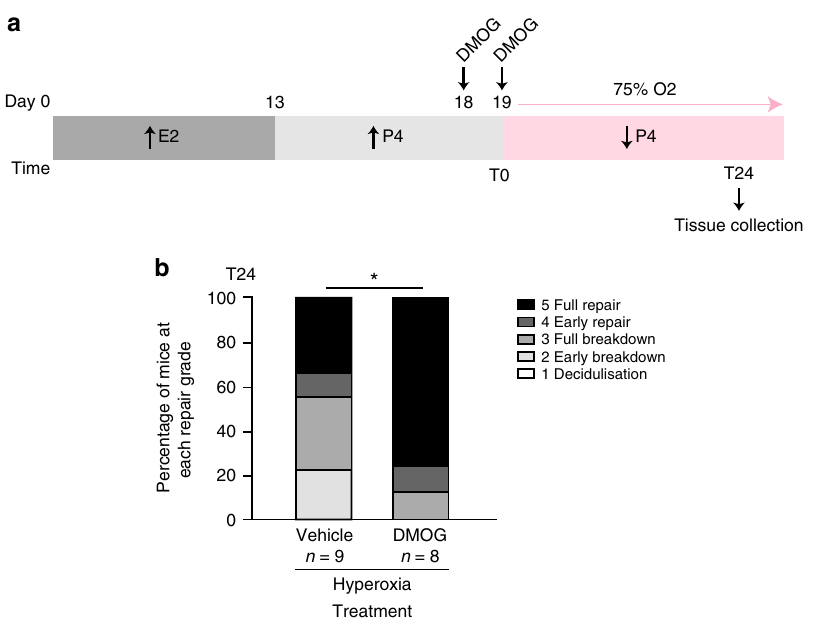
Fig. 6 DMOG rescues the delayed endometrial repair phenotype in the mouse non-hypoxic menstruation model. a Mouse non-hypoxic menstruation model with intraperitoneal dimethyloxalylglycine (DMOG) treatment 24 h before and at the time of P4 withdrawal (T0). E2 estradiol, P4 progesterone. b Endometrial histological breakdown/repair score 24 h following P4 withdrawal (T24) for mice treated with DMOG or vehicle prior to placement in hyperoxic conditions (75% O2). Graphs represent percentage of mice at each histological grade per experimental group. * P < 0.05, Mann – Whitney